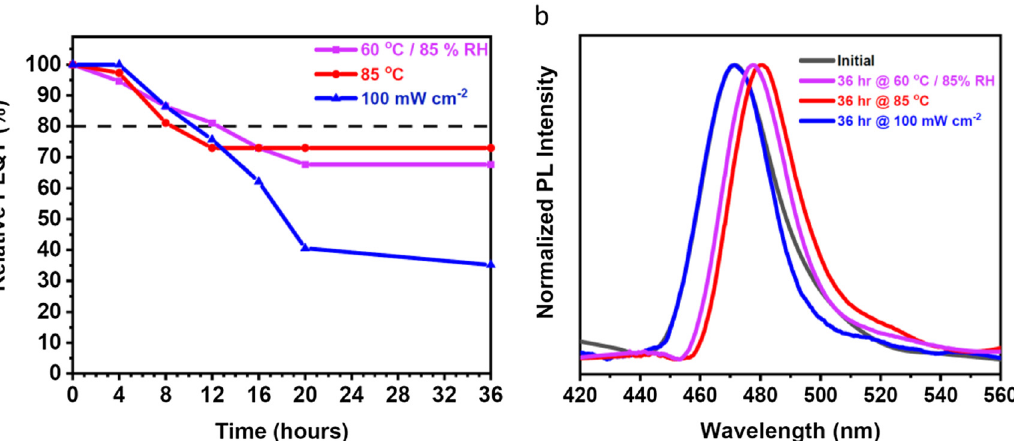
Figure 8: (a) Relative PL quantum yield and (b) the normalized PL spectra after 36 h under the different stability test conditions. The blue line represents the PLQY under 100 mW/cm 2 (450 nm, blue light) irradiation at 50 ° C. The red line represents the PLQY at 85 ° C. The pink line represents the PLQY in 85% relative humidity at 60 ° C [136].